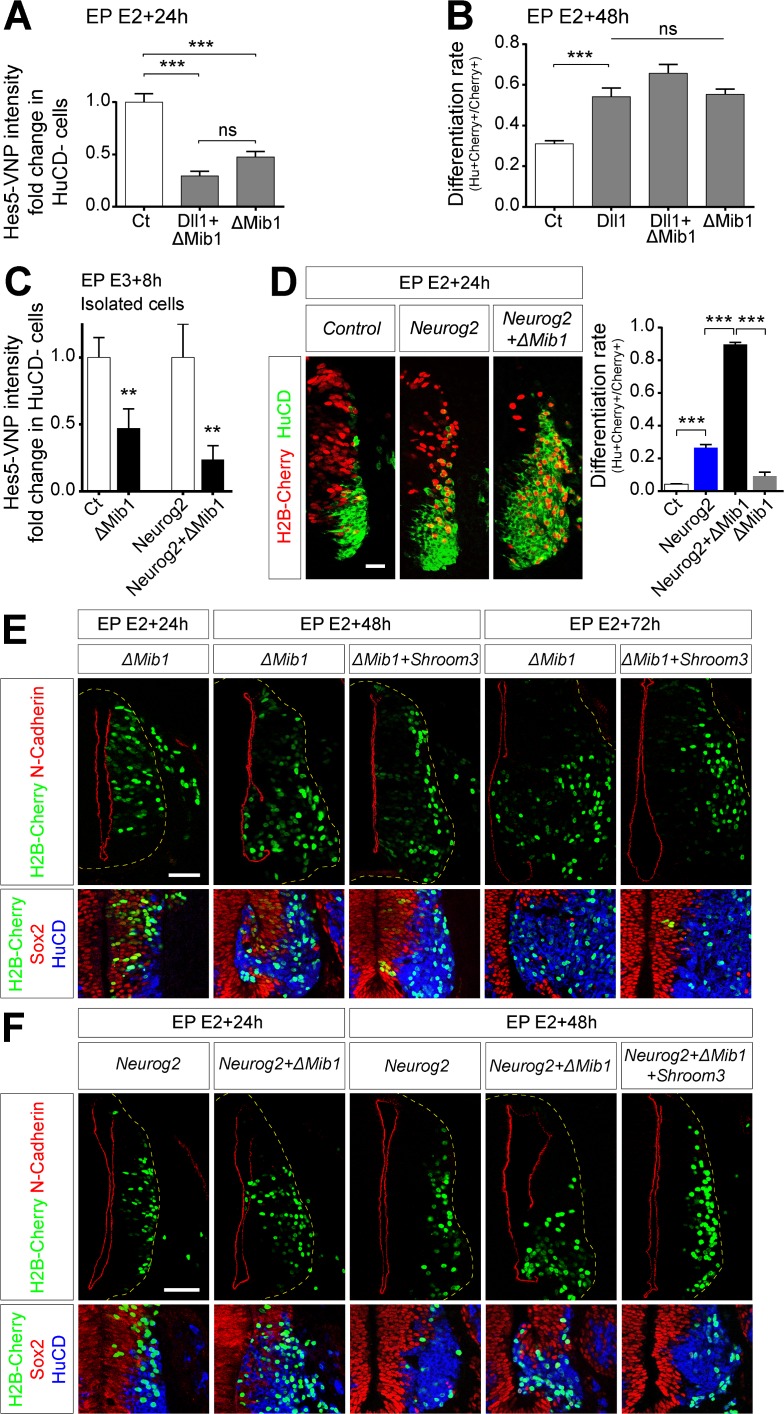
Mib1 blocks Notch Cis-inhibition to defer differentiation and preserve neuroepithelial integrity.(A) Quantification of Hes5-VNP intensity in HuCD− cells transfected with the indicated constructs at E2 and harvested 24 hae. Data represent fold change compared to control. A minimum of 108 cells were analyzed for each group. ns, p > 0.05; ***p < 0.001 (Kruskal-Wallis test). (B) Quantification of the differentiation rate (number of HuCD+ cells on total transfected cells). Data represent mean + SEM. n = 12 (3 embryos), 13 (6 embryos), 15 (6 embryos), 12 (4 embryos) sections were analyzed for control, Dll1, Dll1+ΔMib1, and ΔMib1, respectively. ns, p > 0.05; ***p < 0.001 (one-way ANOVA). (C) Quantification of the Hes5-VNP signal intensity in HuCD− and isolated cells transfected at E3 with the indicated constructs at low voltage (15 V) and harvested 8 h later. Data represent fold change compared to control. n = 37 (3 embryos), 31 (7 embryos), 15 (3 embryos), and 25 (4 embryos) cells were analyzed for control, ΔMib1, Neurog2, and Neurog2+ΔMib1, respectively. **p < 0.01 (Mann-Whitney U test). (D) Left: Transverse sections of the NT transfected at E2 with the indicated constructs, harvested at E3 and immunostained for HuCD (green) to label neurons. Transfection is reported by H2B-Cherry expression. Right: Quantification of the differentiation rate (number of HuCD+ cells on total transfected cells). Data represent mean + SEM. For 24 hae, n = 14, 12, 19, 7 sections collected from six embryos for each experimental group were analyzed for control, Neurog2, Neurog2+ΔMib1, and ΔMib1, respectively. ***p < 0.001 (one-way ANOVA). Underlying data are provided in S1 Data. (E, F) Transverse sections of the NT transfected at E2 with the indicated constructs and immunostained for N-Cadherin (red); and for Sox2 (red) and HuCD (blue) to label progenitors and neurons, respectively. Transfection is reported by H2B-Cherry expression (green). Scale bar represents 50 μm. ΔMib1, dominant-negative Mib1; Ct, control; Dll1, Delta-like 1; E, embryonic day; EP, electroporation; hae, hour after electroporation; Hes5, Hairy and Enchancer of Split 5; HuCD, neuron-specific RNA-binding proteins HuC and HuD; H2B-Cherry, Histone 2B fused to Cherry; Mib1, Mindbomb1; Neurog2, Neurogenin 2; ns, nonsignificant; NT, neural tube; Shroom3, shroom family member 3; Sox2, Sox2, SRY (sex determining region Y) box 2; VNP, Venus-NLS-PEST.